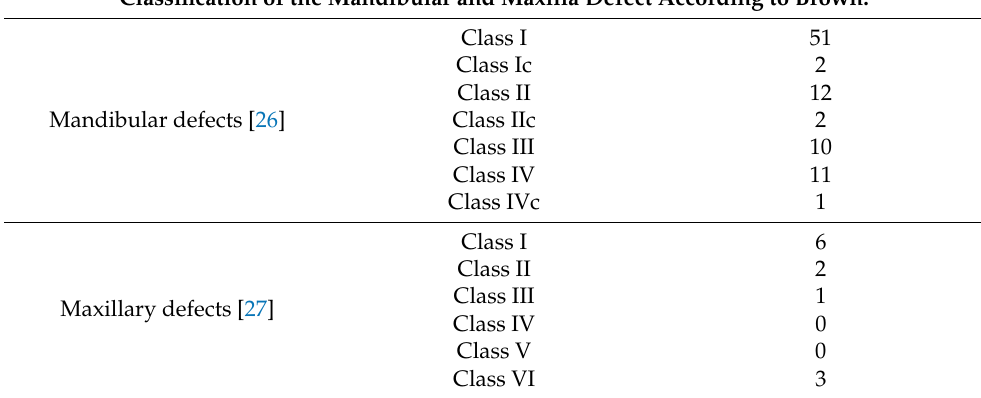
Table 3. Distribution of Mandibular and Maxilla Defects of the Patient Cohort According to the Brown Classification System.